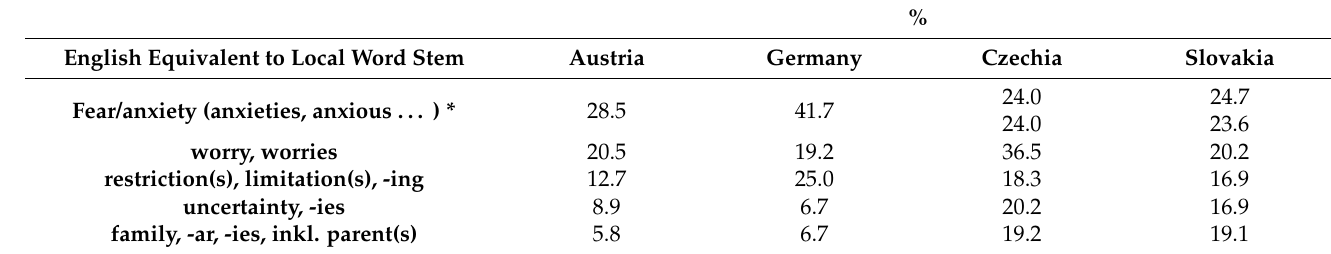
Table 1. The percentage of the five most frequent word stems in all four countries was ordered by total. * Fear/anxiety refers to only one word stem in the German language but to two word stems in the Czech and Slovak languages. More comprehensive tables by country with word stems occurring with more than 5% frequency in the responses are included in the supplementary